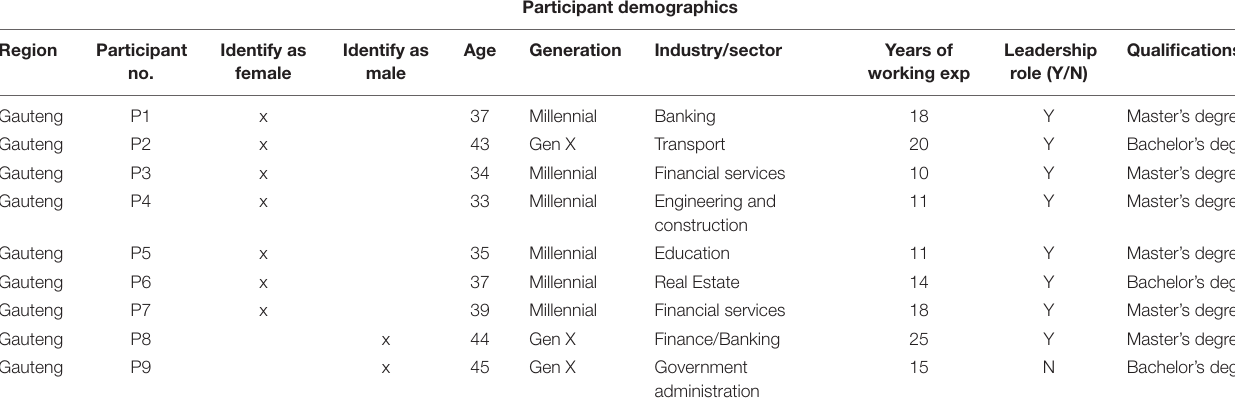
TABLE 1 | Participant